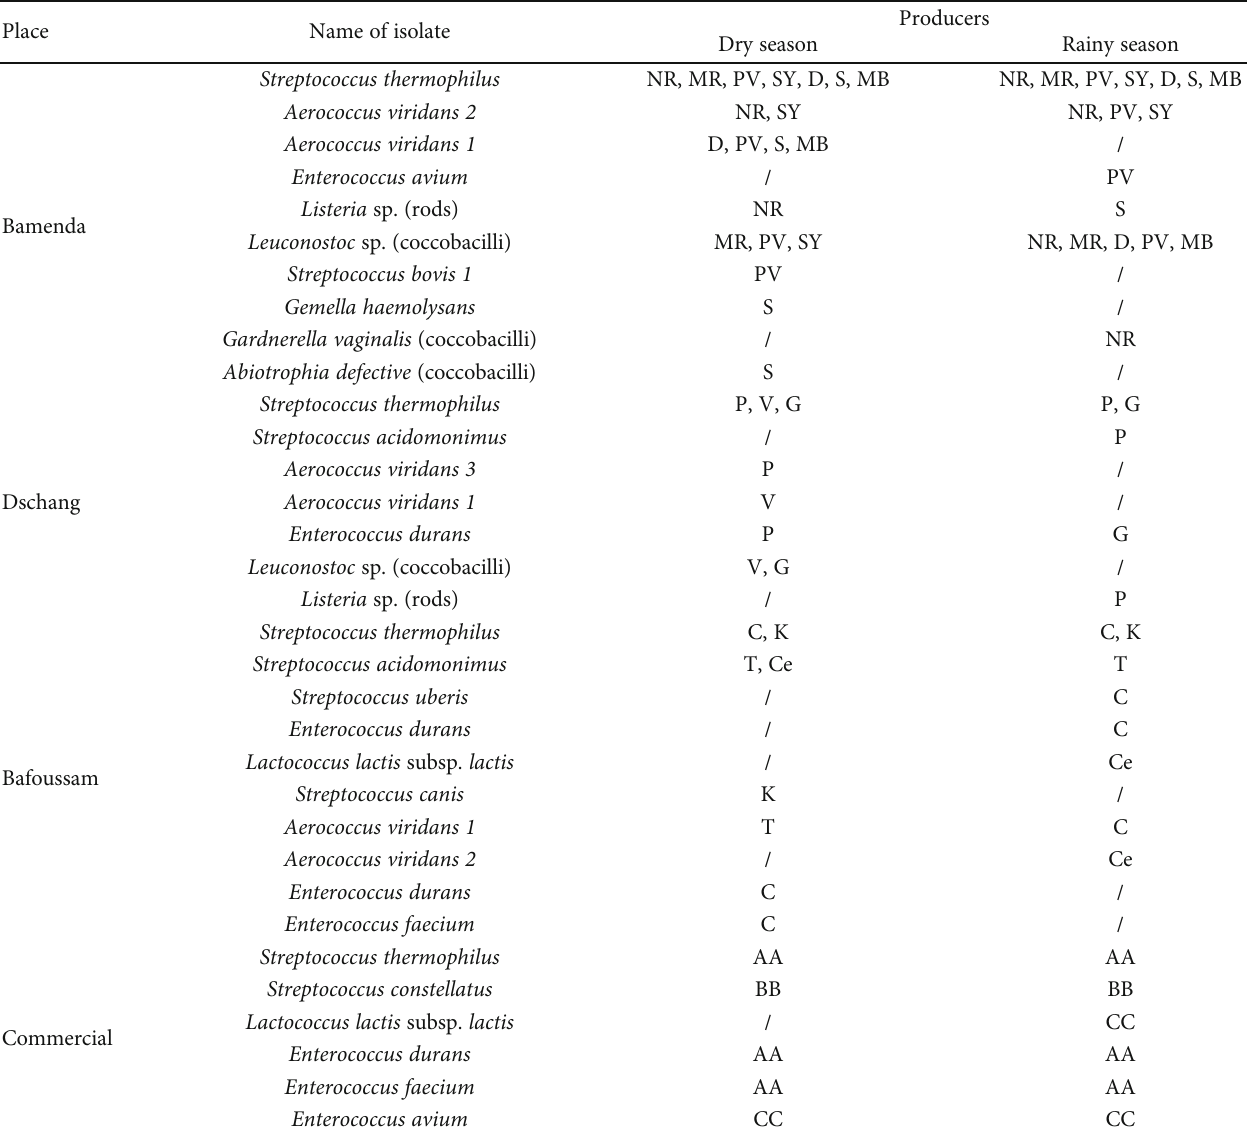
Table 4: Cocci, coccobacilli, and rod species found in yoghurt samples during the rainy and dry season.